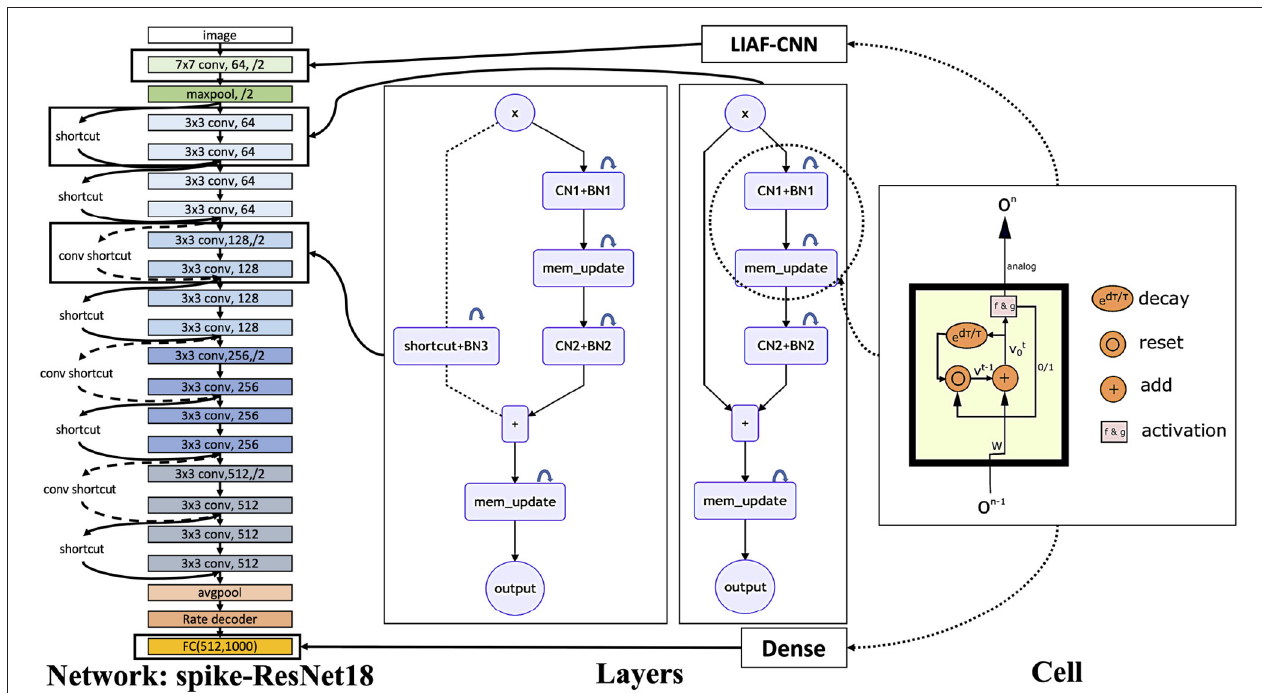
FIGURE 8 | SNN structure used in the experiments. On the right, we show the internal structure of LIAF neurons. By changing synaptic connections, we can obtain a variety of layer structures, where CN denotes the convolutional layer and BN denotes the 3D-BatchNorm layer. Using these layers, we can build a scalable LIAF residual network